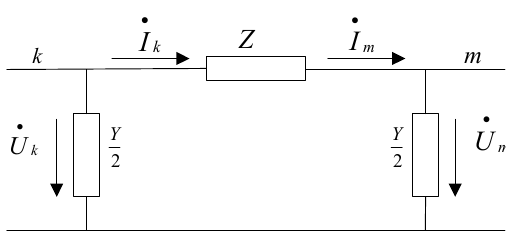
Figure 1. Equivalent circuit for transmission line.